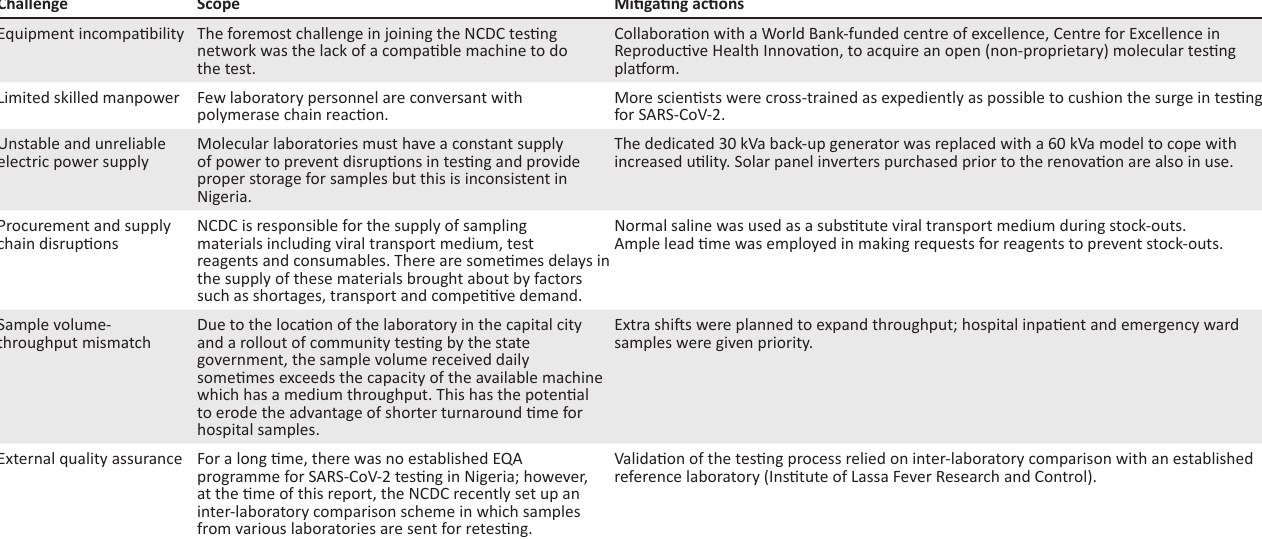
TABLE 1: Challenges of setting up of SARS-CoV-2 testing in University of Benin Teaching Hospital and mitigating actions taken, Edo state, Nigeria, 2020. Challenge Scope Mitigating